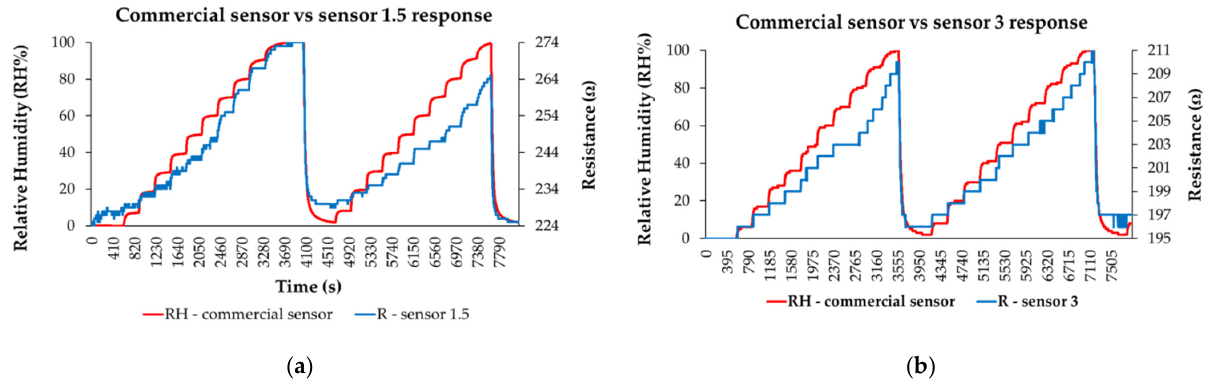
8 of 17 Figure 6. Raman spectra of solid-state films of CNHox /SnO 2 /ZnO /PVP = 3/1/1/1 (mass ratio) de-